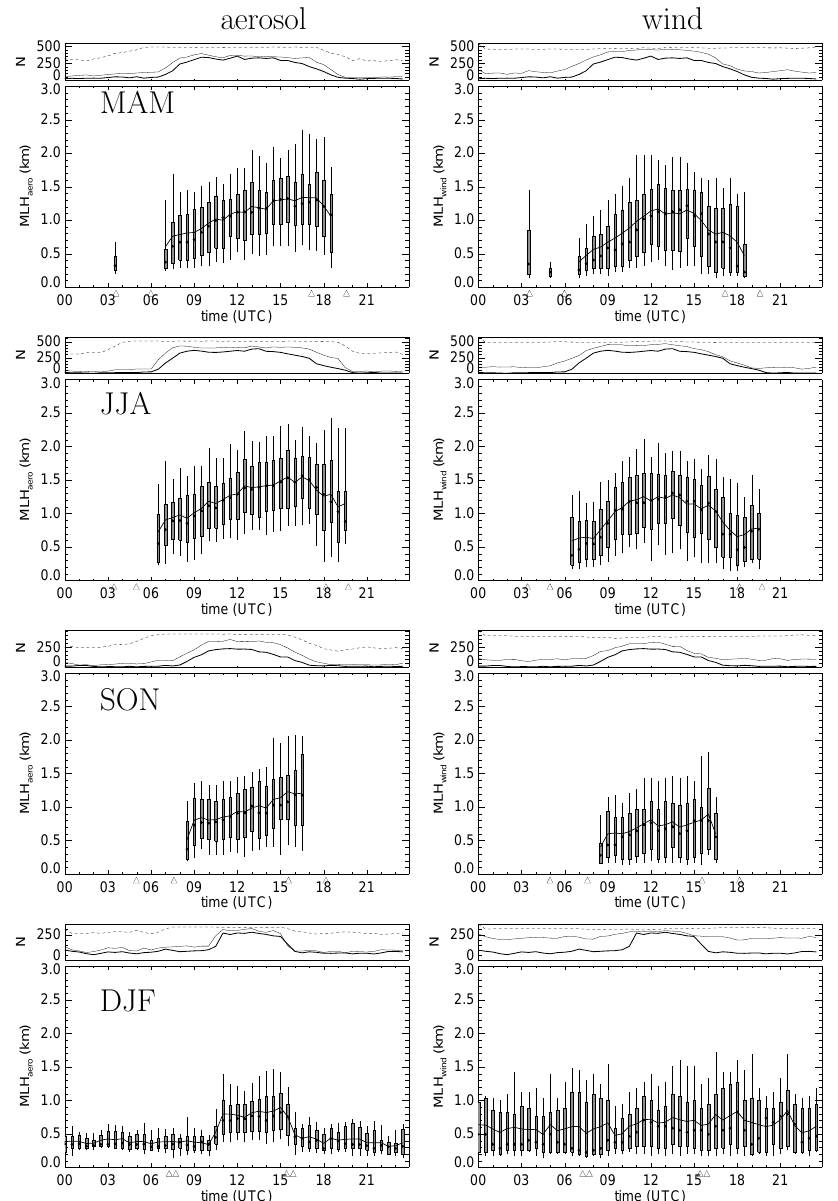
Figure 6. Average diurnal course (solid line) of MLH from aerosol (left panels) and vertical wind (right panels) for spring (MAM), summer (JJA), autumn (SON) and winter (DJF). Whiskers and boxes indicate 10, 25, 75 and 90% percentiles. The centre dot indicates the median. On top of every subplot the number of cases N is shown before excluding any data (dashed line), after excluding data below 120m (solid thin line) and after synchronizing with the other instrument (solid thick line). Triangles at the abscissa mark range of sunrise and sunset during the respective